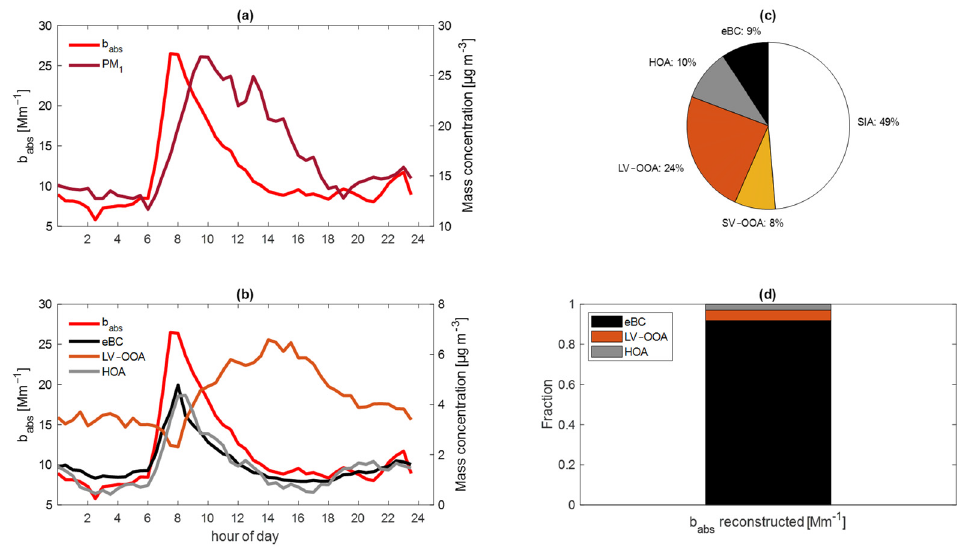
Figure 4. The average diurnal profile of ( a ) the absorption coefficient and PM 1 and ( b ) eBC, HOA, and LV–OOA. ( c ) Average percent mass composition of PM 1 . ( d ) Contribution of eBC, LV–OOA, and HOA to the light-absorption at 532 nm.